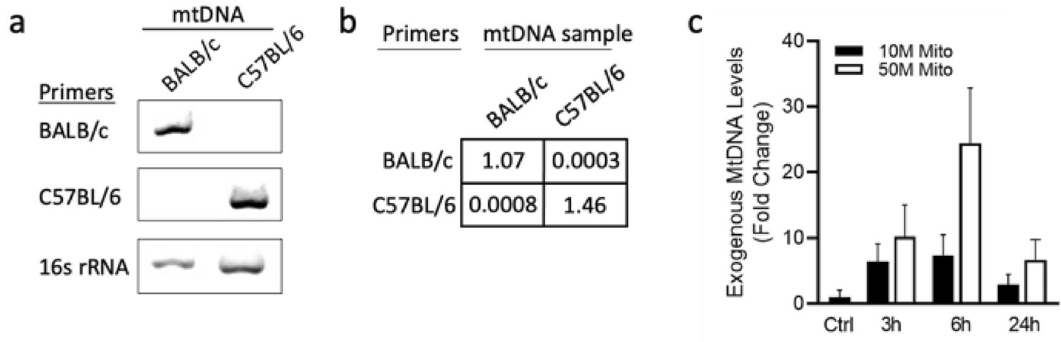
Figure 3. Assessment of exogenous mitochondrial survival by qPCR. ( a ) mtDNA from either BALB/c or C57BL/6 mice was amplified by PCR using primers specific for BALB/c or C57BL/6, or against 16S, a common target, as indicated. ( b ) qPCR analysis using specific primers for mtDNA from BALB/c and C57BL/6. Levels were normalized to D-loop (an identical sequence in both mtDNA sequences) and are represented as the relative quantification of the specific primers. ( c ) Survival rate of the transplanted mitochondria. One million 661W cells (C57BL/6 origin) were transplanted with either 10 million or 50 million (M) mitochondria that were isolated from BALB/c mouse liver. After 3, 6, or 24 hours, RNA was extracted from the cells and presence of exogenous BALB/c mitochondria was assessed by qPCR. n =